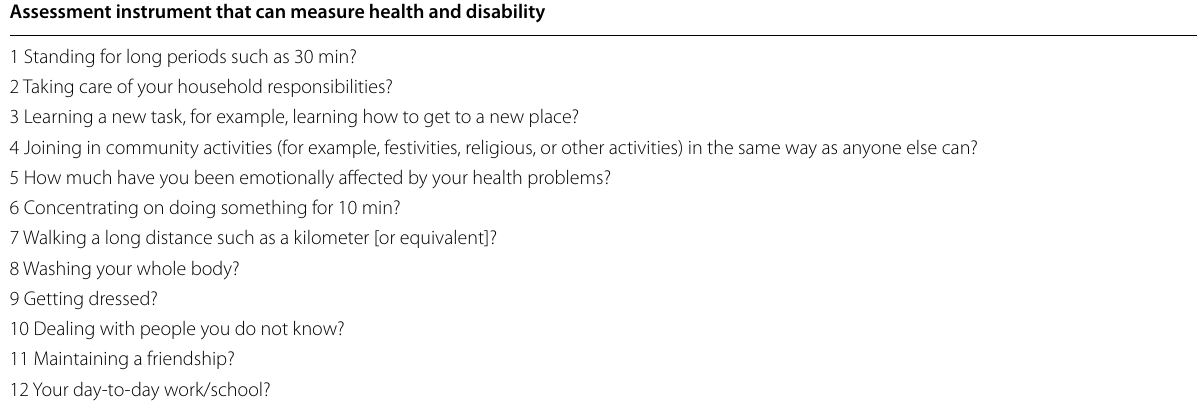
Table 2 The 12-item world health organization disability assessment schedule